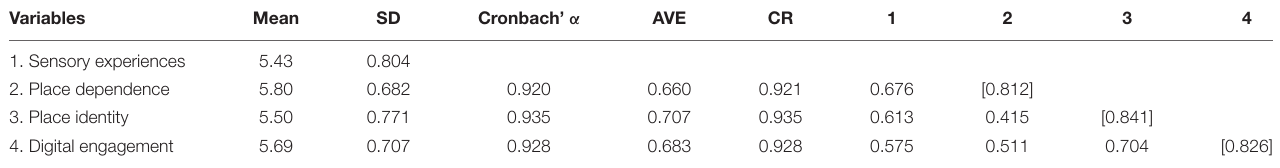
TABLE 4 | Means, SD, Cronbach’ α , CR, and AVE.